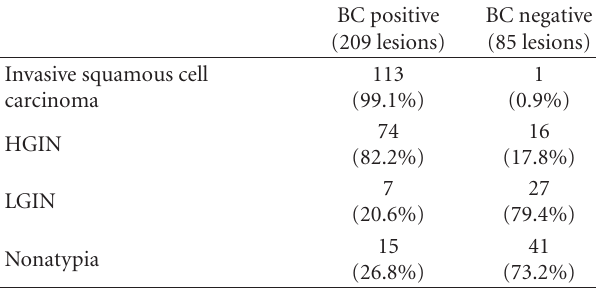
Table 1: Histological diagnosis for 294 esophago-pharyngeal lesions. More than 90% of BC positive lesions were histologically confirmed as HGIN or SCC. On the other hand, 80.0% of BC nega- tive group were diagnosed as noncancer, P < 0 . 0001.